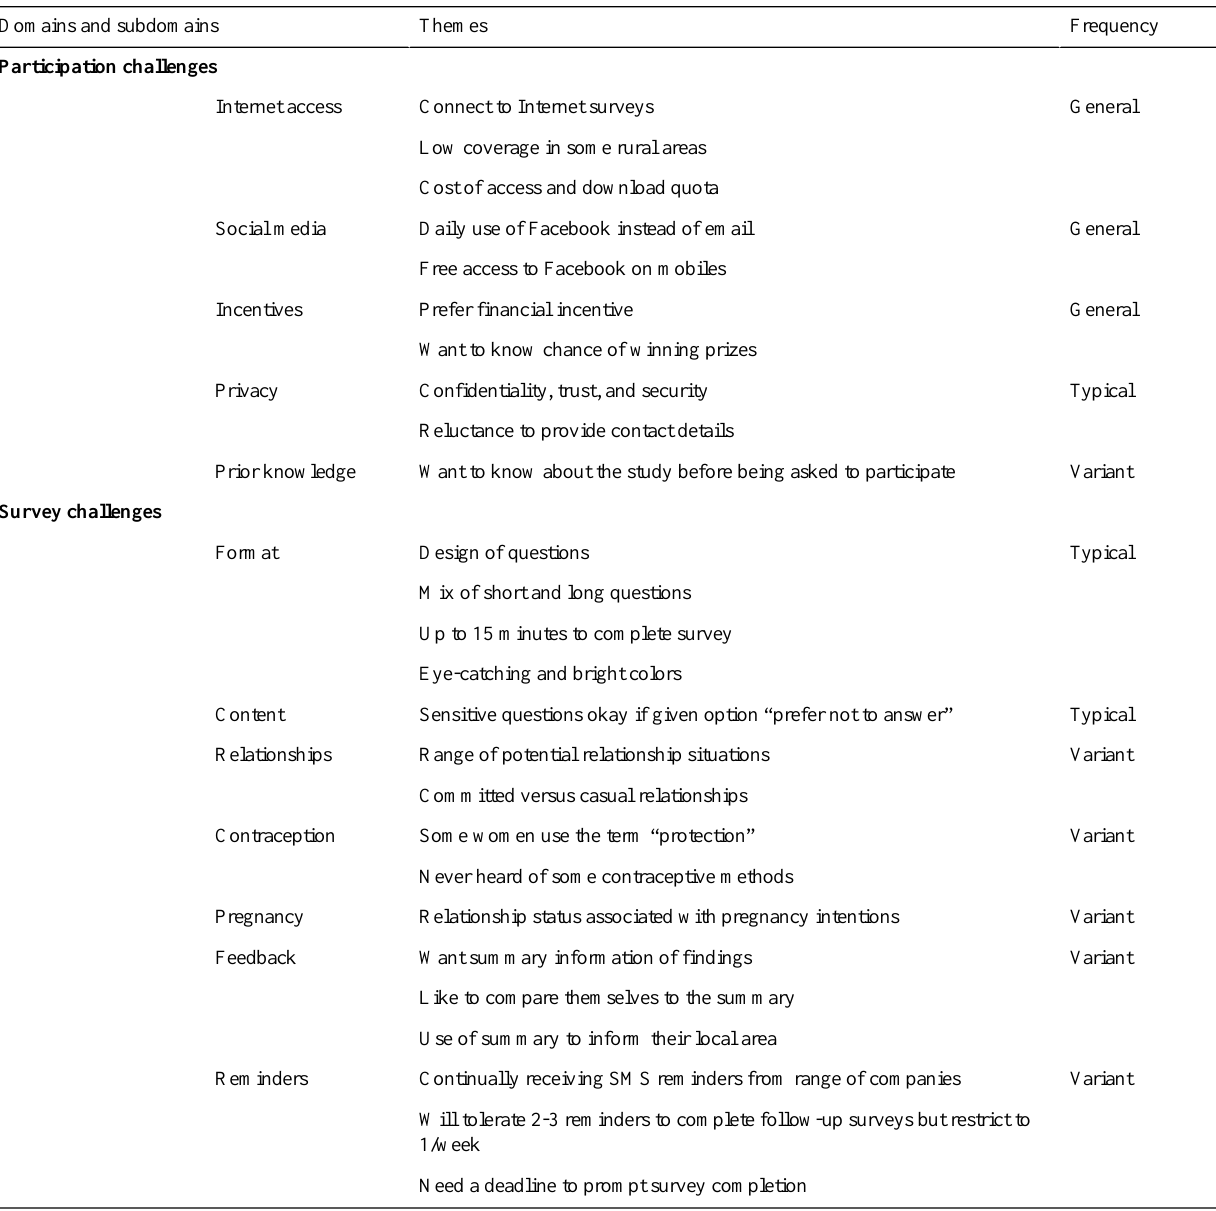
Table 2. Thematic analysis of focus group discussions (General = 19-20 participants, Typical = 10-18 participants, Variant = 1-9